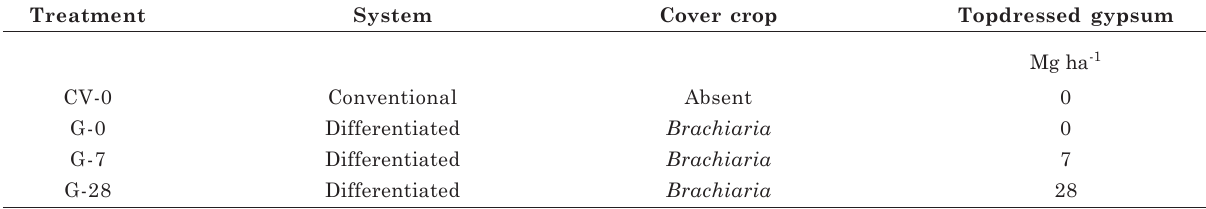
Table 2. Experimental treatments of coffee under different management systems